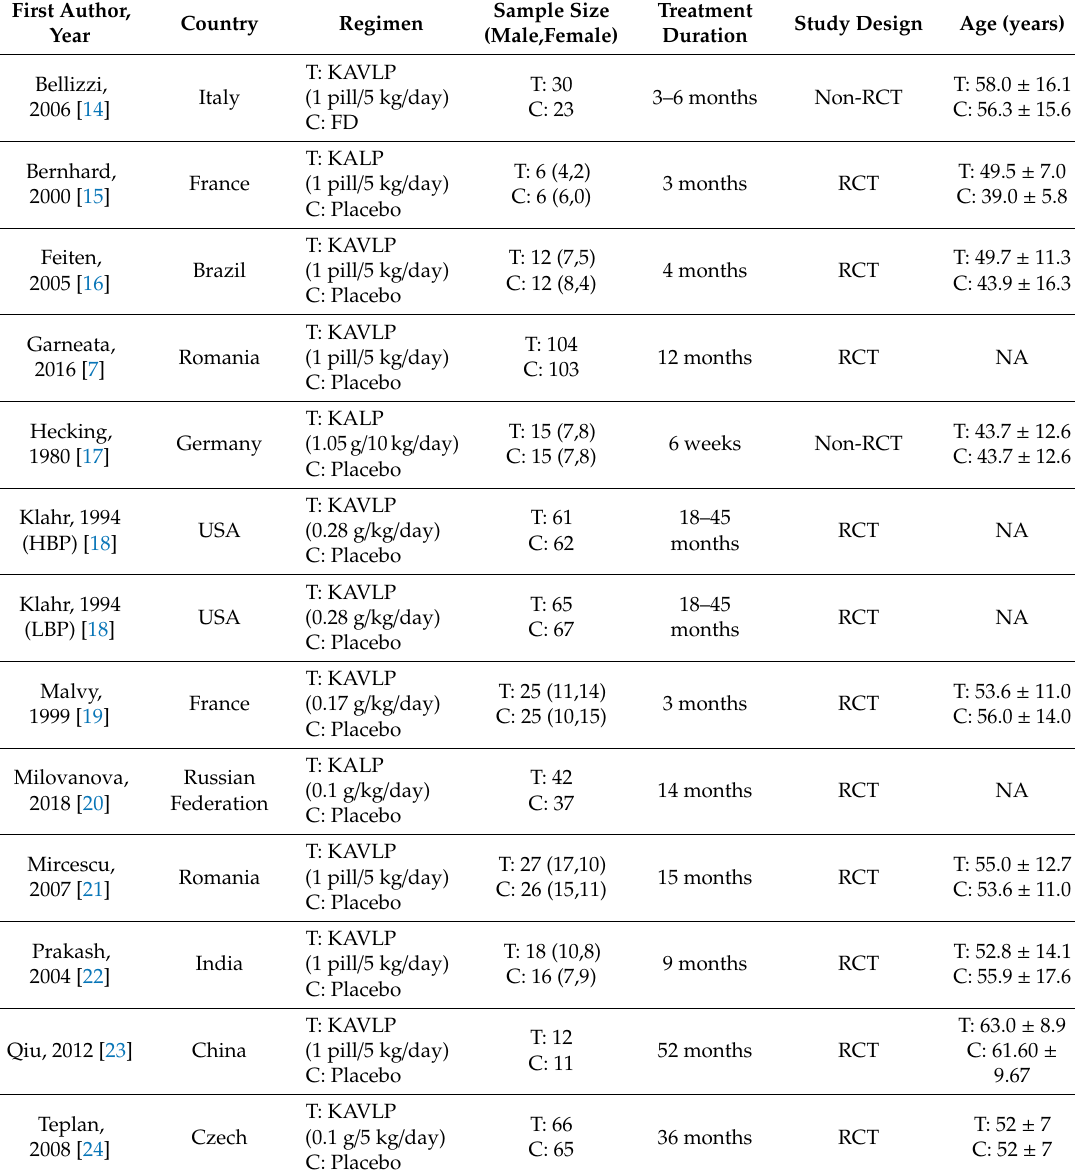
Table 1. Characteristics of the selected